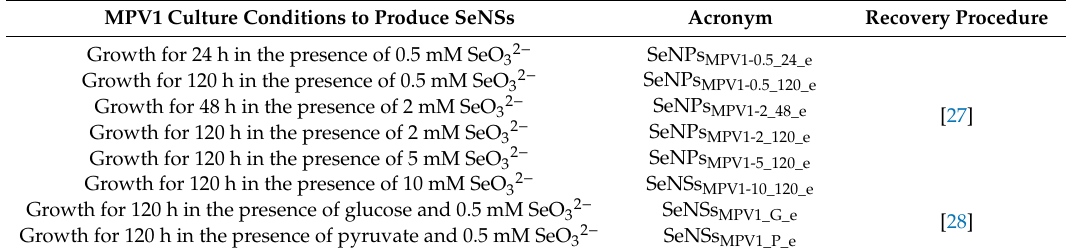
Table 2. Conditions used to produce biogenic SeNS extracts, their acronyms and procedures used for their recovery from MPV1